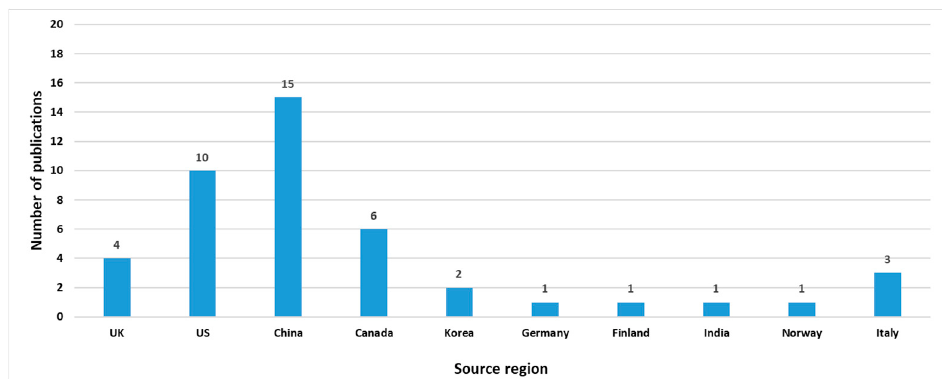
Figure 4. International affiliation of included publications.